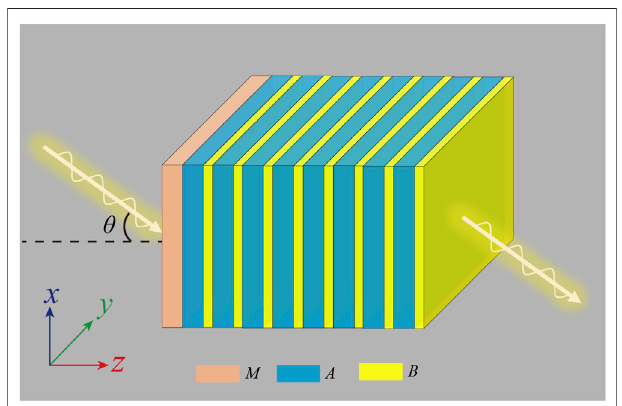
FIGURE 1 | Schematic of the heterostructure composed of a magnetized isotropic ENZ layer M and a truncated PC: ( AB ) n . M , A , and B correspond to the Ag, SiO 2 , and TiO 2 , respectively. The incident electromagnetic waves launch into the structure from the left at an incident angle θ